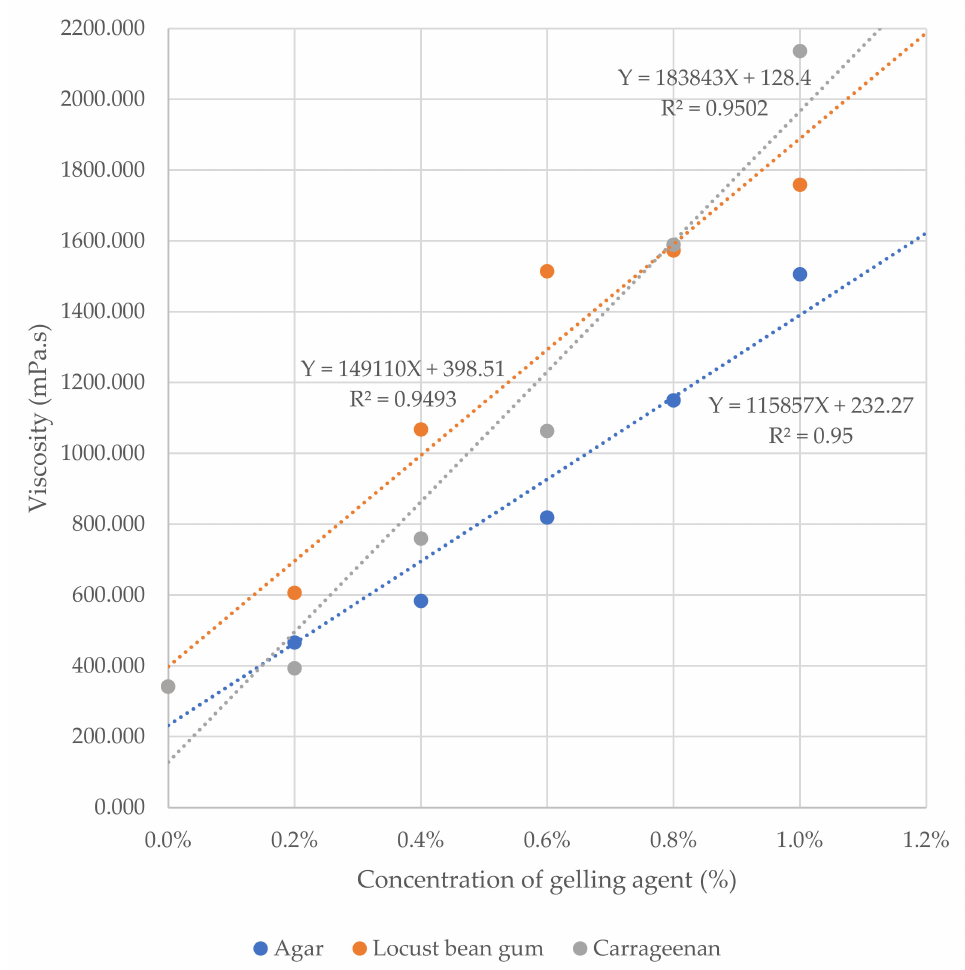
Figure 1. Regression equation for the viscosity of the custard added with roasted Tonka bean by gelling agent. The Y-scale is “viscosity (mPa.s)”, and the X-scale is “concentration of gelling agent (%)”. The coefficient of determination (R 2 ) is a number between 0 and 1 that measures how well a statistical model predicts an outcome, and a higher coefficient is an indicator of a better goodness of fit for the observations. KS for elder-friendly foods has set a standard that a viscosity of 1500 mPa.s or less is appropriate for fluid foods for the